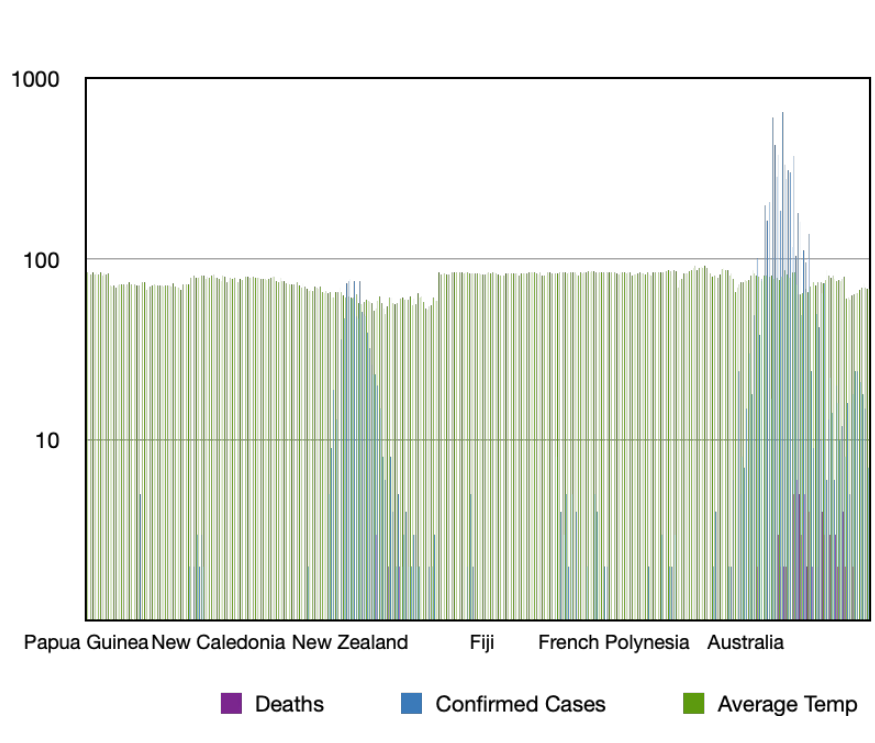
Fig. 10 . Drivers of COVID-19 in the region of